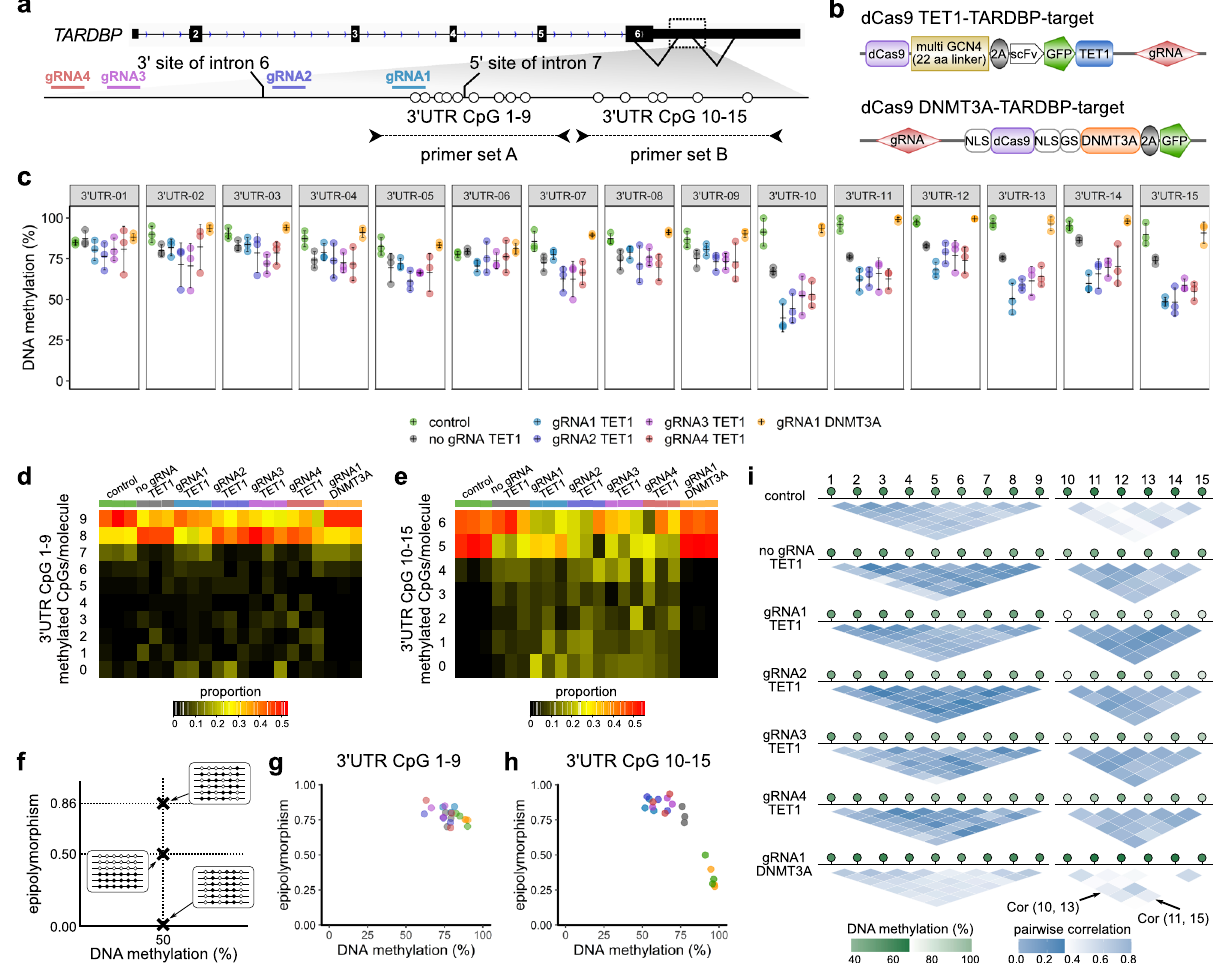
Fig. 2 Targeted manipulation of the DNA methylation status of the TARDBP 3 ′ UTR. a Schematic of the CpG sites of the TARDBP gene, the target regions of the guide RNAs (gRNA1, 2, 3, and 4), and primer sets A and B used for the bisul fi te amplicon sequencing. b Structure of the vectors used in the experiment. c Percent DNA methylation at 3 ′ UTR CpGs 1 – 15 in HEK293T cells (mean ± SD, n = 3). d, e Proportions of the number of sequence reads classi fi ed by the number of CpGs methylated among nine CpG sites (3 ′ UTR CpGs 1 – 9) or six CpG sites (3 ′ UTR CpGs 10 – 15). f Schematic of epipolymorphisms showing methylation pro fi les with the same mean methylation level but different methylation patterns within the CpG region. Black and white circles represent methylated CpGs and demethylated CpGs, respectively. g, h Scatterplot showing the epipolymorphism score of the DNA methylation percentage. i Methylation linkage diagram of 3 ′ UTR CpGs 1 – 9 and 3 ′ UTR CpGs 10 – 15 showing the correlation of all CpG-site pairs in the target region. Green circles indicate the mean percentage of DNA methylation at each CpG